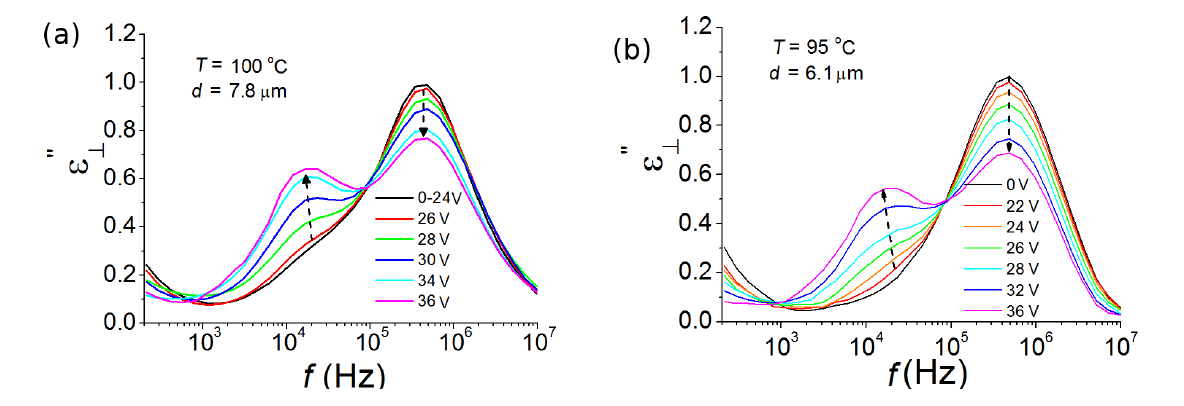
Figure 5: Dependence of the dielectric loss spectrum ( ε″ ) on the DC bias voltage (0–36 V) in the nematic phase close to the N–Iso transition tempera- ture for (a) 7.8 µm BCN66 cell at 100 °C and (b) 6.1 µm BCN84 cell at 95 °C [51].